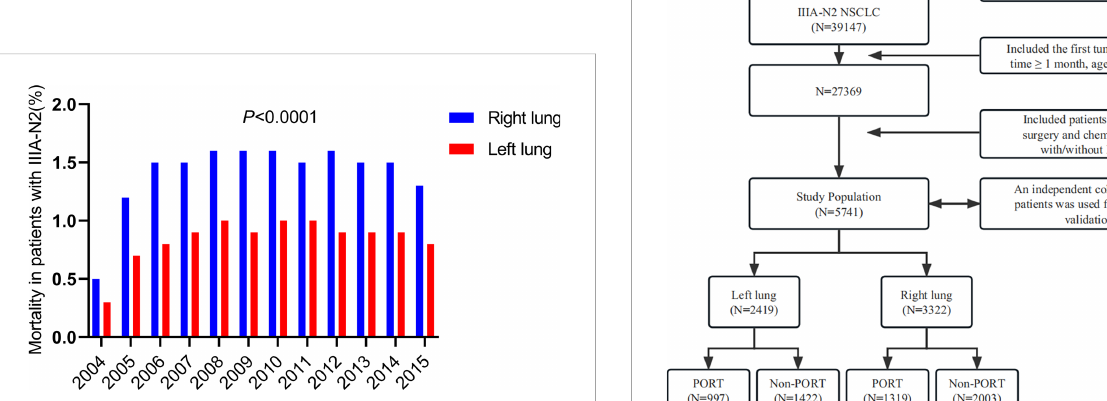
FIGURE 1 Temporal trends of different causes of death.